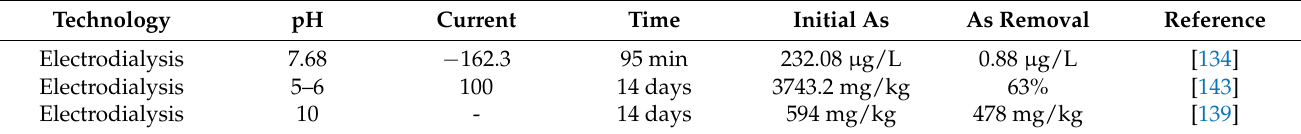
Table 7. Arsenic removal from water by electrodialysis